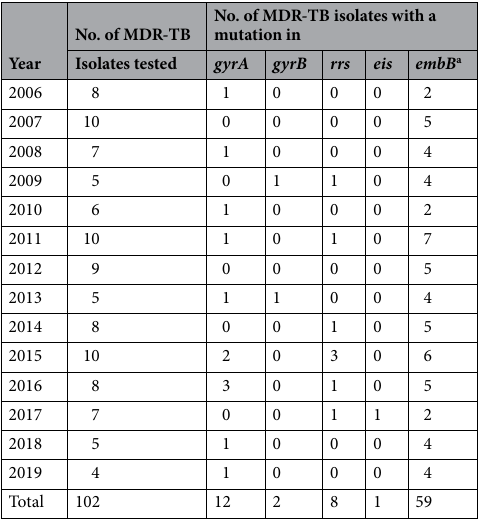
Table 4. The year-wise prevalence of gyrA/gyrB, rrs/eis and embB mutations in multidrug-resistant M. tuberculosis (MDR-TB) isolates analyzed during the 14-year study period. a embB codon 306 mutations